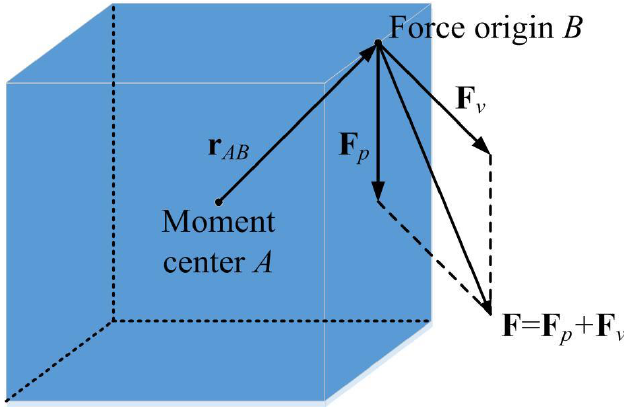
Figure 6. Moment vector of a fluid micro-element of abrasive flow.